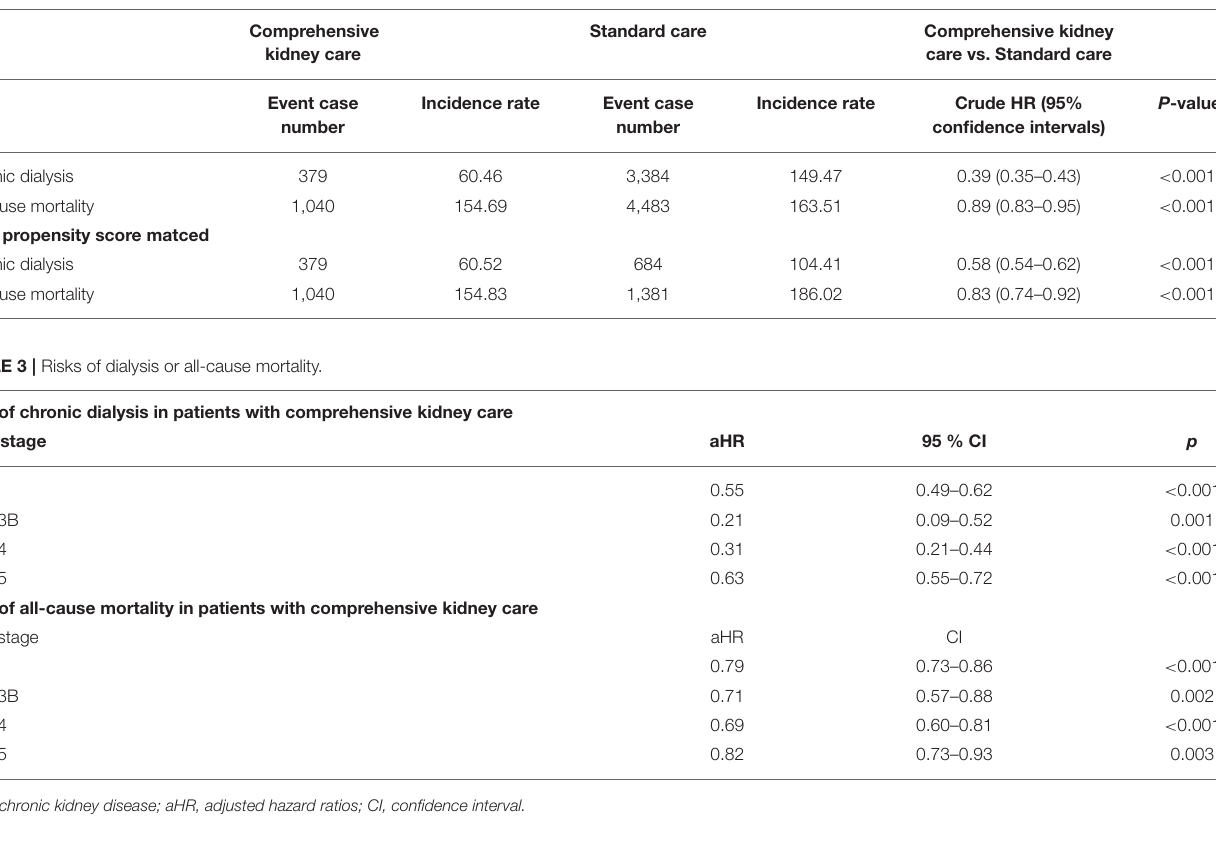
TABLE 2 | Outcomes of dialysis-requiring acute kidney injury survivors receiving comprehensive kidney care or standard care.